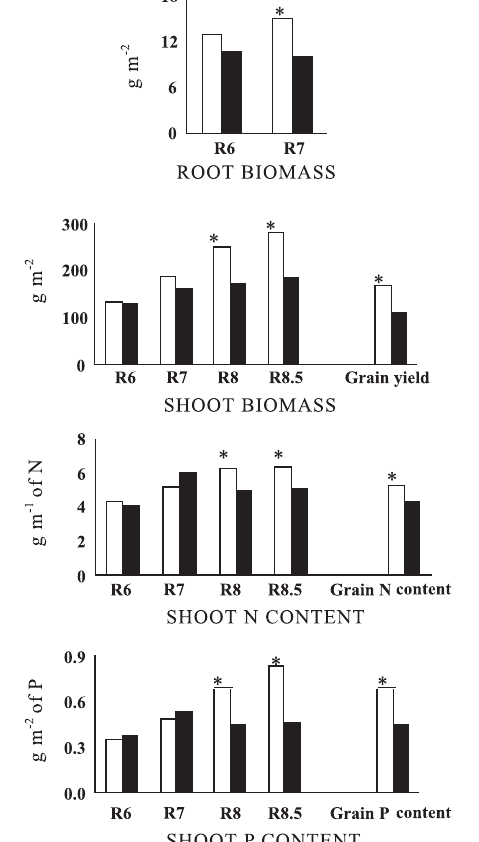
Figure 3. Combined analysis over years of root mass at two growth stages, shoot mass at four growth stages, grain yield at maturity, shoot N and